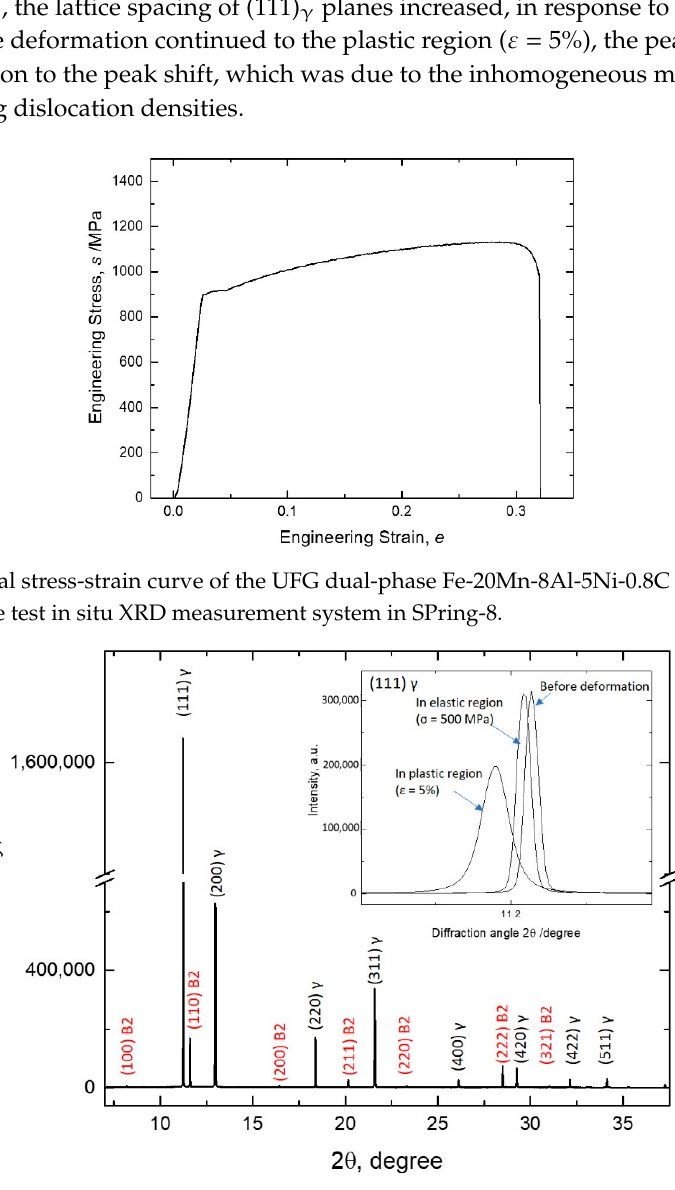
Figure 5. A diffraction profile measured before loading of the UFG Fe-20Mn-8Al-5Ni-0.8C alloy during the tensile test with in situ XRD measurements. The changing of the (111) peak of austenite ( γ phase) during the tensile test is shown in the insets, in which the peak shifting and peak broadening during the tensile test are illustrated.